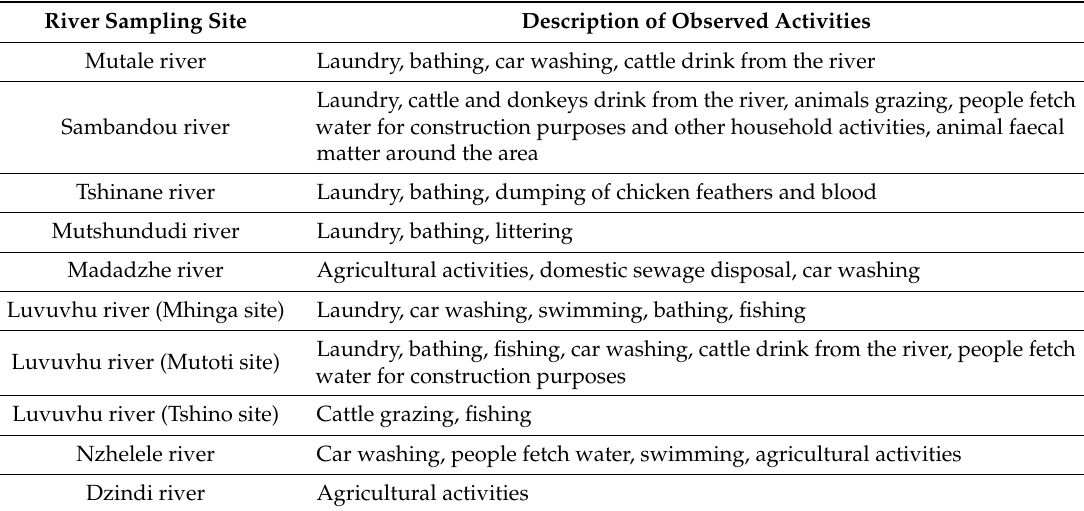
Table 1. Activities seen around the selected river water